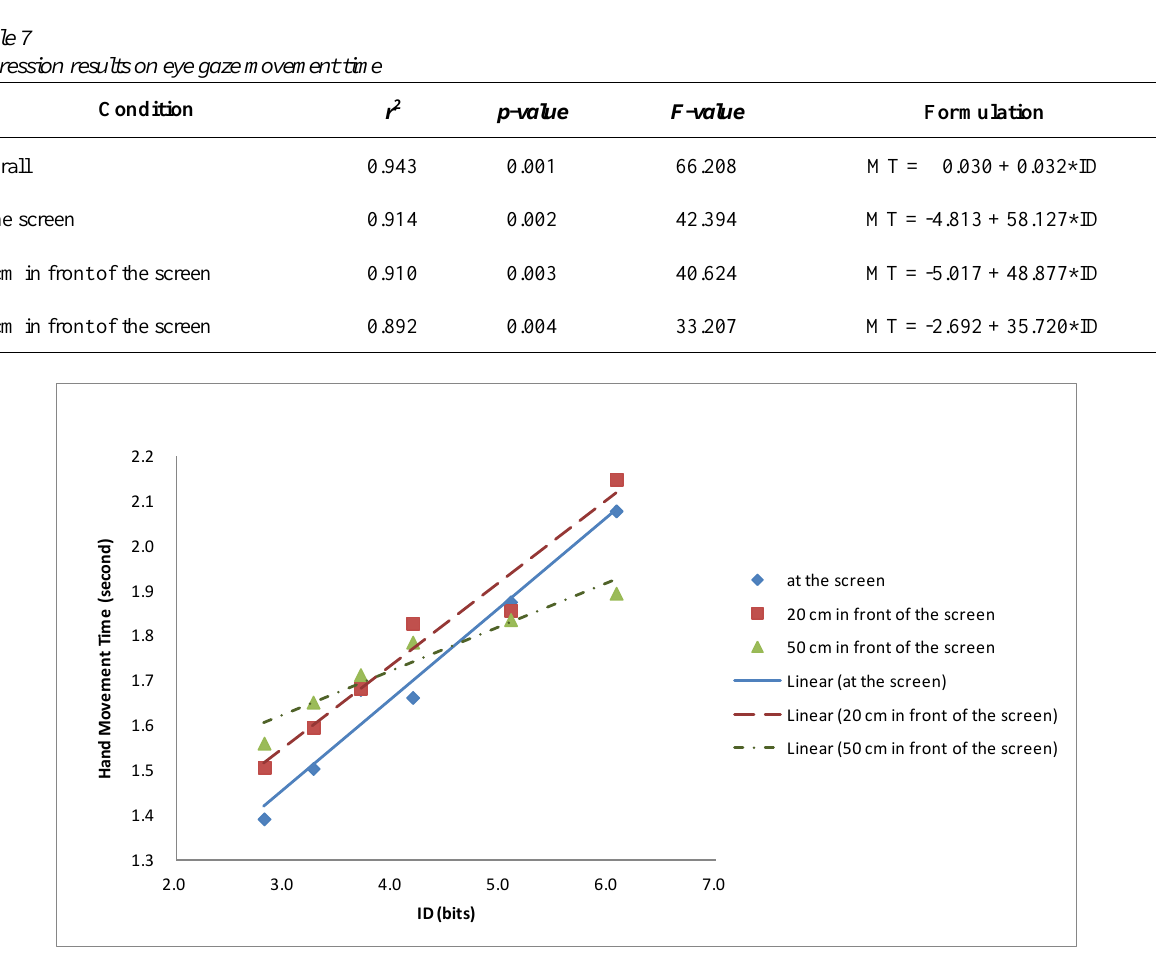
The plot present regression lines per parallax level for hand movement time (second) as a function of index of difficulty (bits). Each line presents the hand movement time fitted line for each parallax condition (at the screen, 20 cm in front of the screen, and 50 cm in front of the screen).